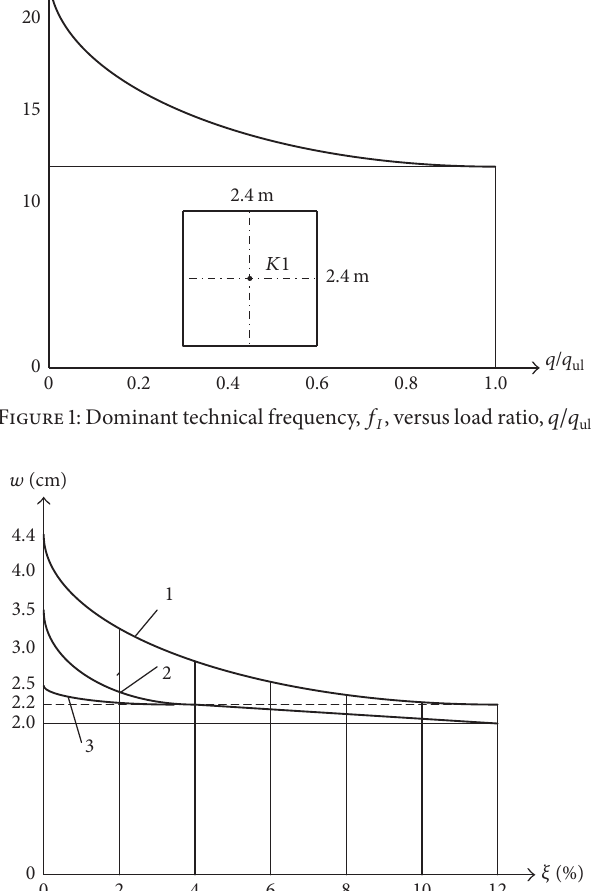
Figure 2: 24 × 24 m shell deflection versus damping ratio for various ground motions: 1: high-frequency earthquake, 2: medium- frequency earthquake, and 3: low-frequency earthquake.